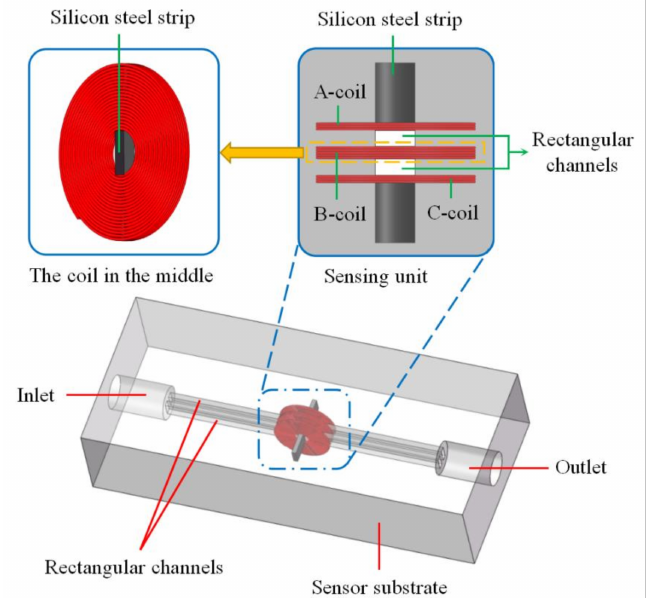
Figure 1. The structure of impedance debris